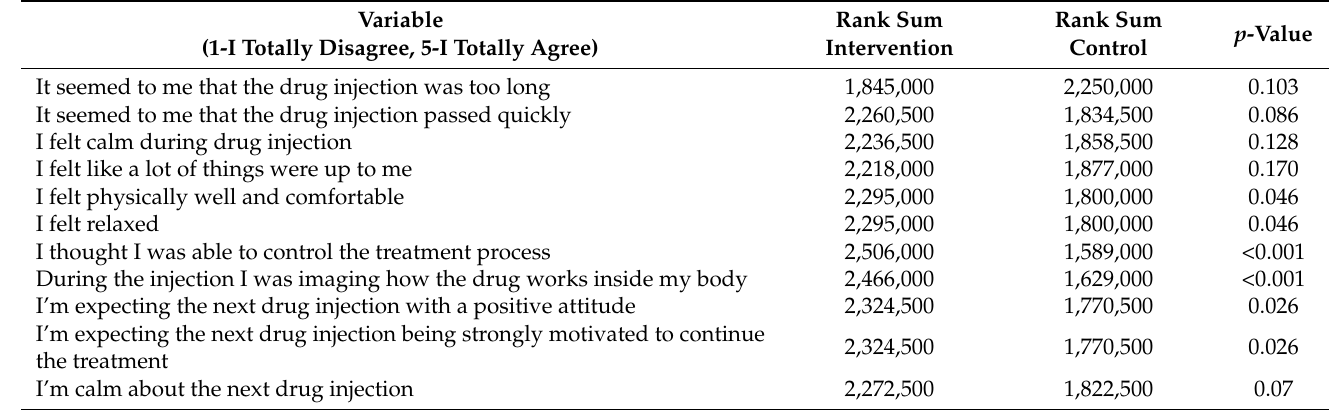
Table 2. The subjective psychological indicators questionnaire summary.